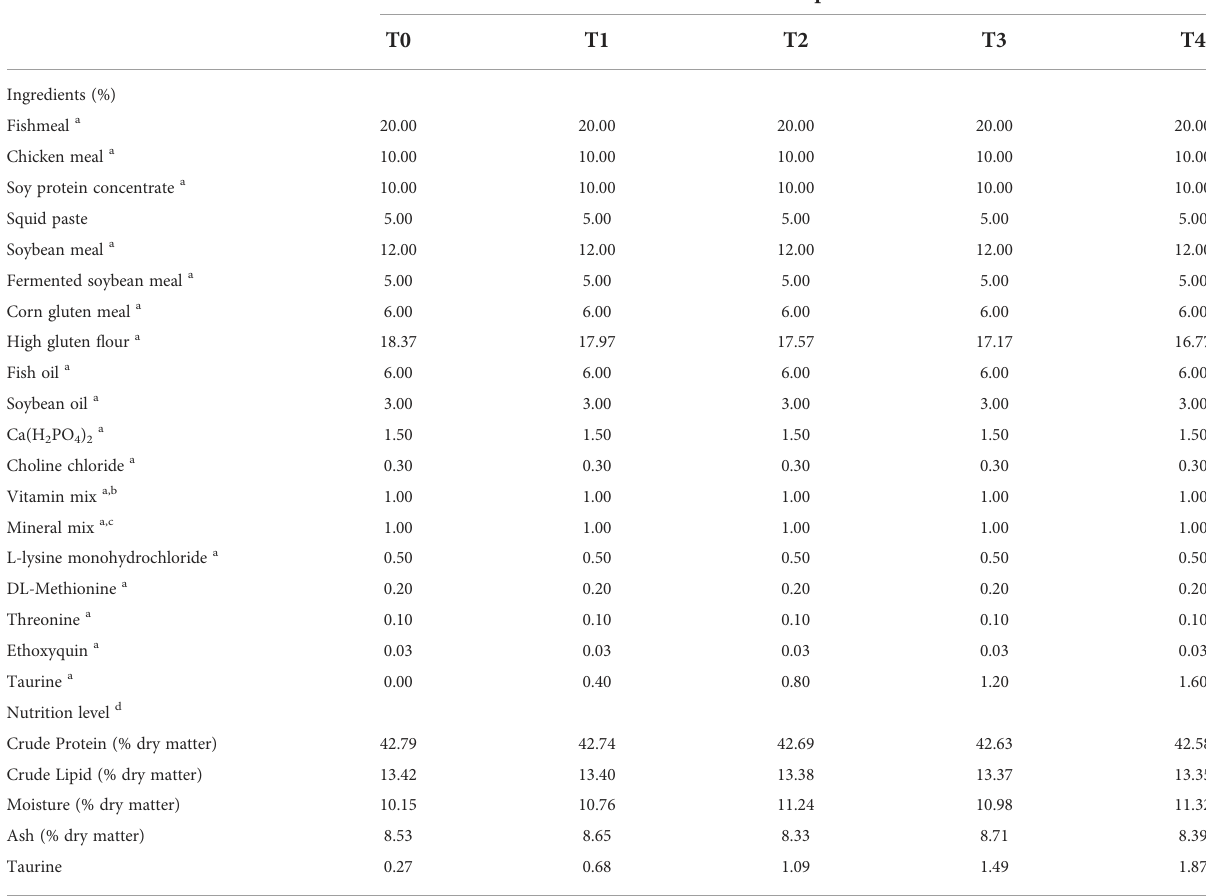
TABLE 1 Formulation and nutrition level of the experimental diets (% dry matter